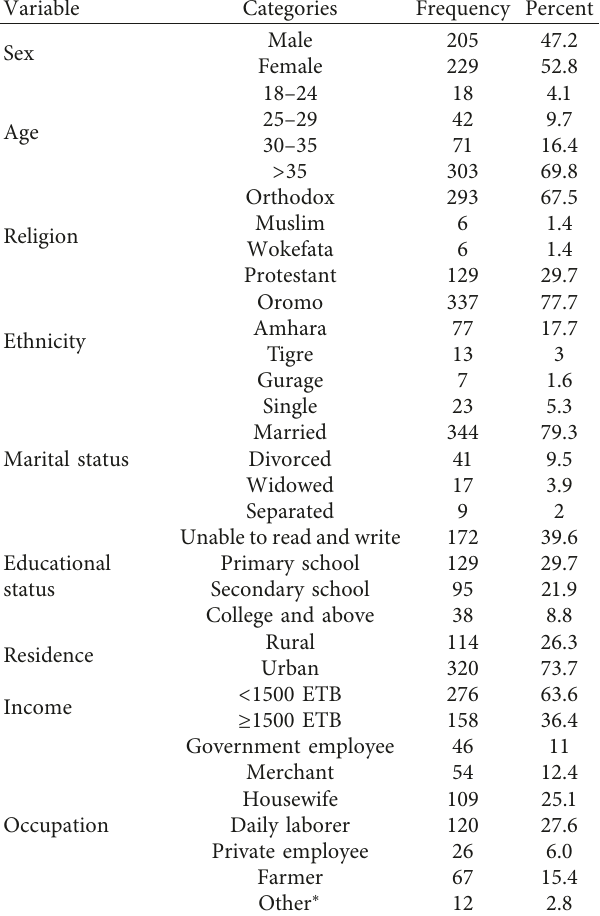
Table 1: Sociodemographic characteristics of adult clients on ART at Holeta Health Center, central Ethiopia,